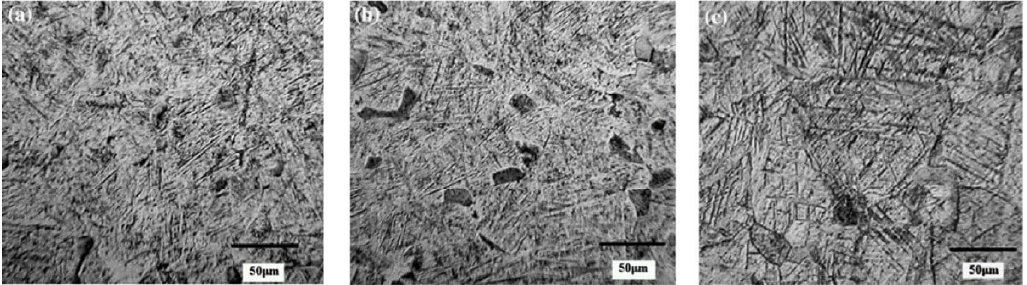
Fig. 4 Metallography images of Ti64 surfaces ST at 1,000 ° C (30 min) and quenched: (a) oil; (b) water; (c) N 2 . Reproduced with permission from Ref. [19]. Copyright Springer Nature,